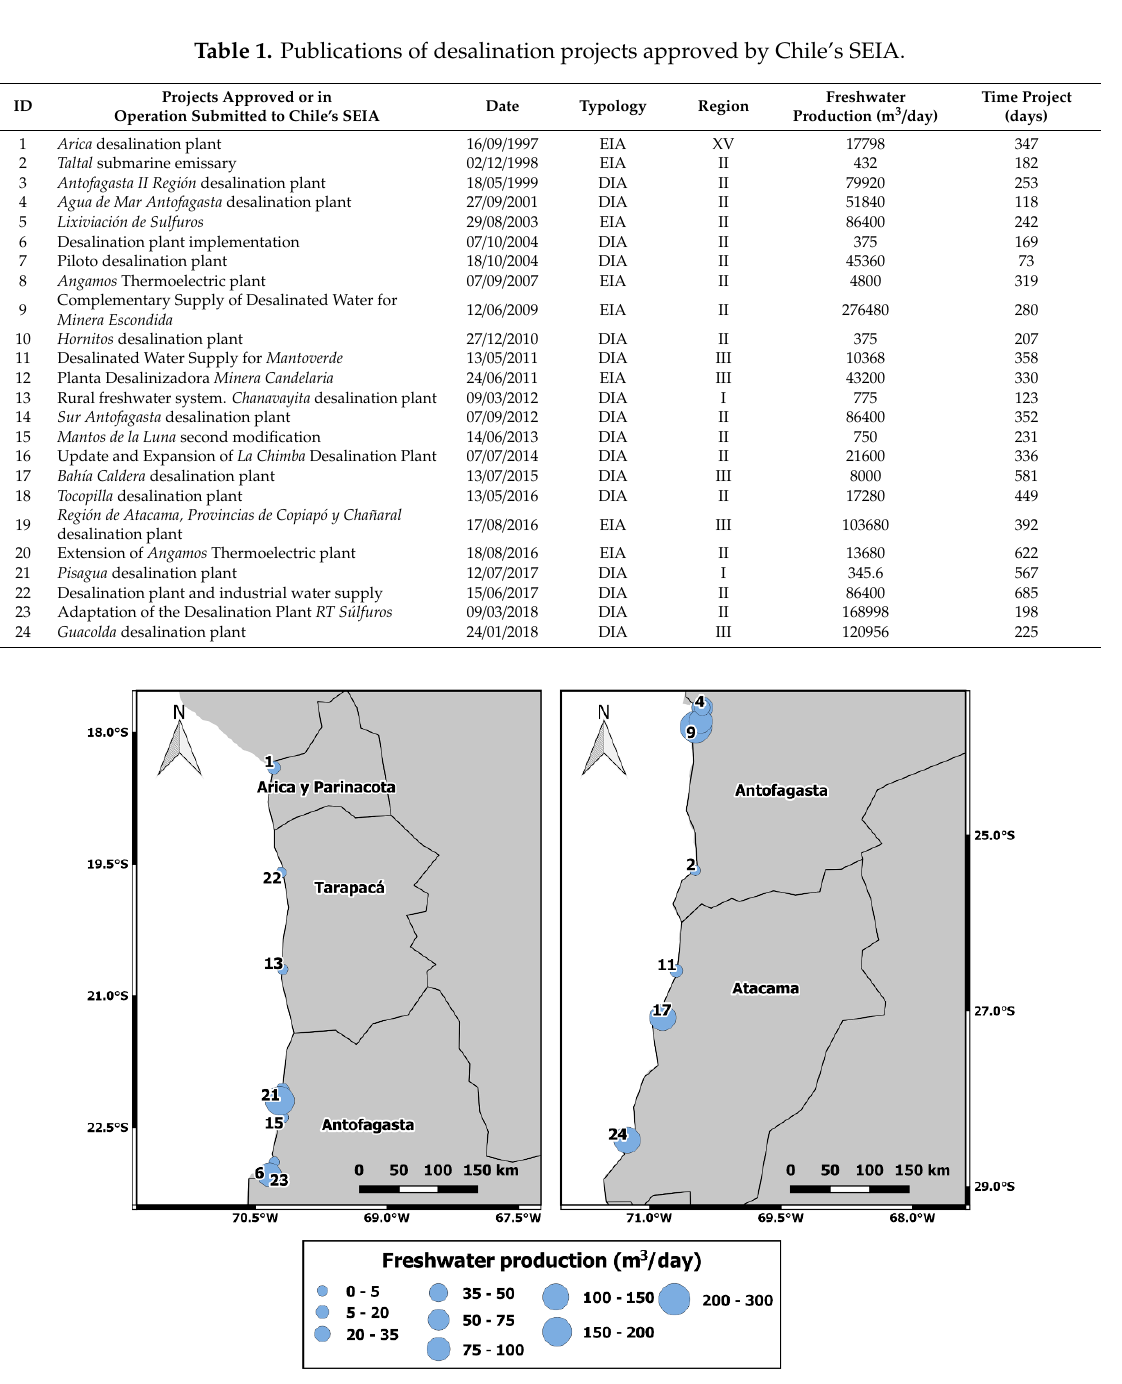
Figure 1. Location of desalination projects and their maximum production capacity (m 3 / day) submitted to the Environmental Impact Evaluation System (SEIA) between 1997 and 2018 in Chile. Table 1. Publications of desalination projects approved by Chile’s SEIA.